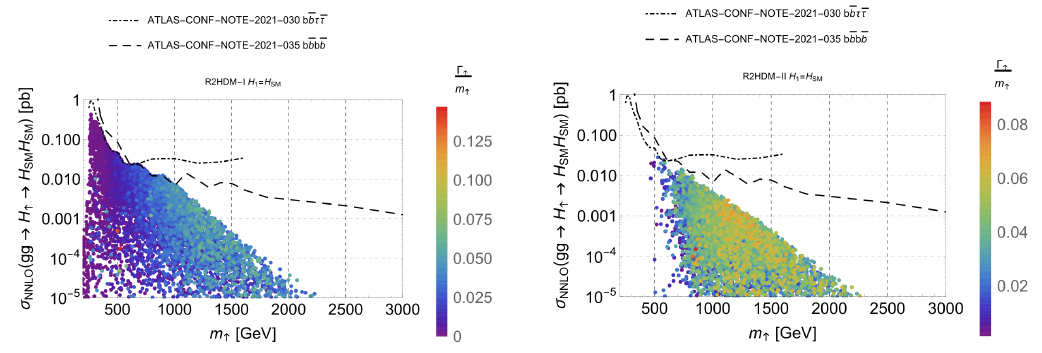
Figure 13 . Resonant production cross sections for the R2HDM points of figure 7 (upper) for R2HDM-I (left) and R2HDM-II (right) as a function of the resonantly produced heavier Higgs boson H . Color code: ratio of the total width of the resonant Higgs boson and its 2 ≡ H ↑